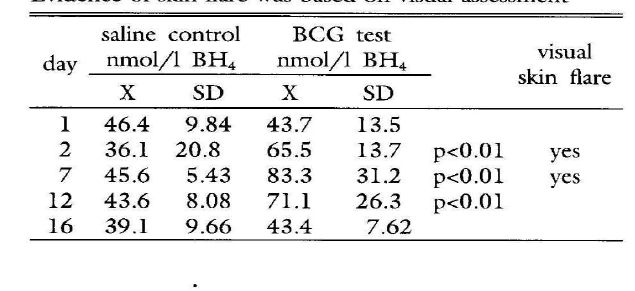
Table 2. Comparison of mean serum BH4 concentration (nmoljl) at different time points between day 30 and day 80. There were no significant diffferences